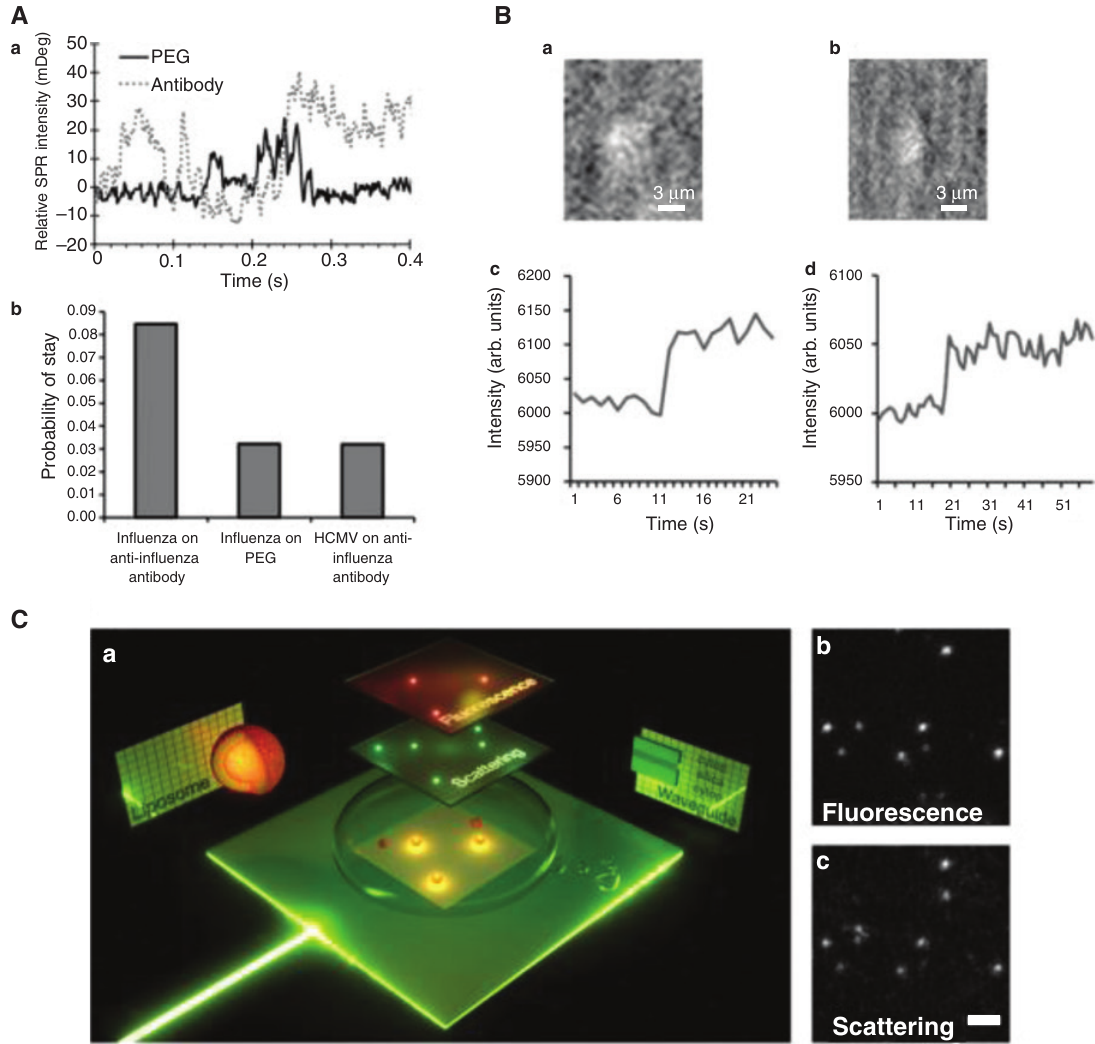
Figure 8: (A) (a) SPR intensity profiles for influenza A viral particles captured on PEG and anti-influenza A antibody-functionalized sensor surfaces. (b) Relative binding probabilities of influenza A on PEG and anti-influenza A antibody-functionalized surfaces, and binding of a dif- ferent virus HCMV on anti-influenza antibody spots as a control. Adapted from [48]. (B) A SPRi micrograph of (a) IAV or (b) HIV-VLP captured functionalized surfaces. Viruses appear as bright spots on grey background. Intensity change with the binding event of IAV and HIV-VLPs is seen in (c) and (d) as signal increase, respectively. Adapted from [35]. (C) (a) Schematic representation of the planar waveguide chip and detection of fluorescently labeled vesicles in (b) fluorescence and (c) scattering modes. Adapted from [80] (Reprinted with permission from [80], Copyright 2015 American Chemical